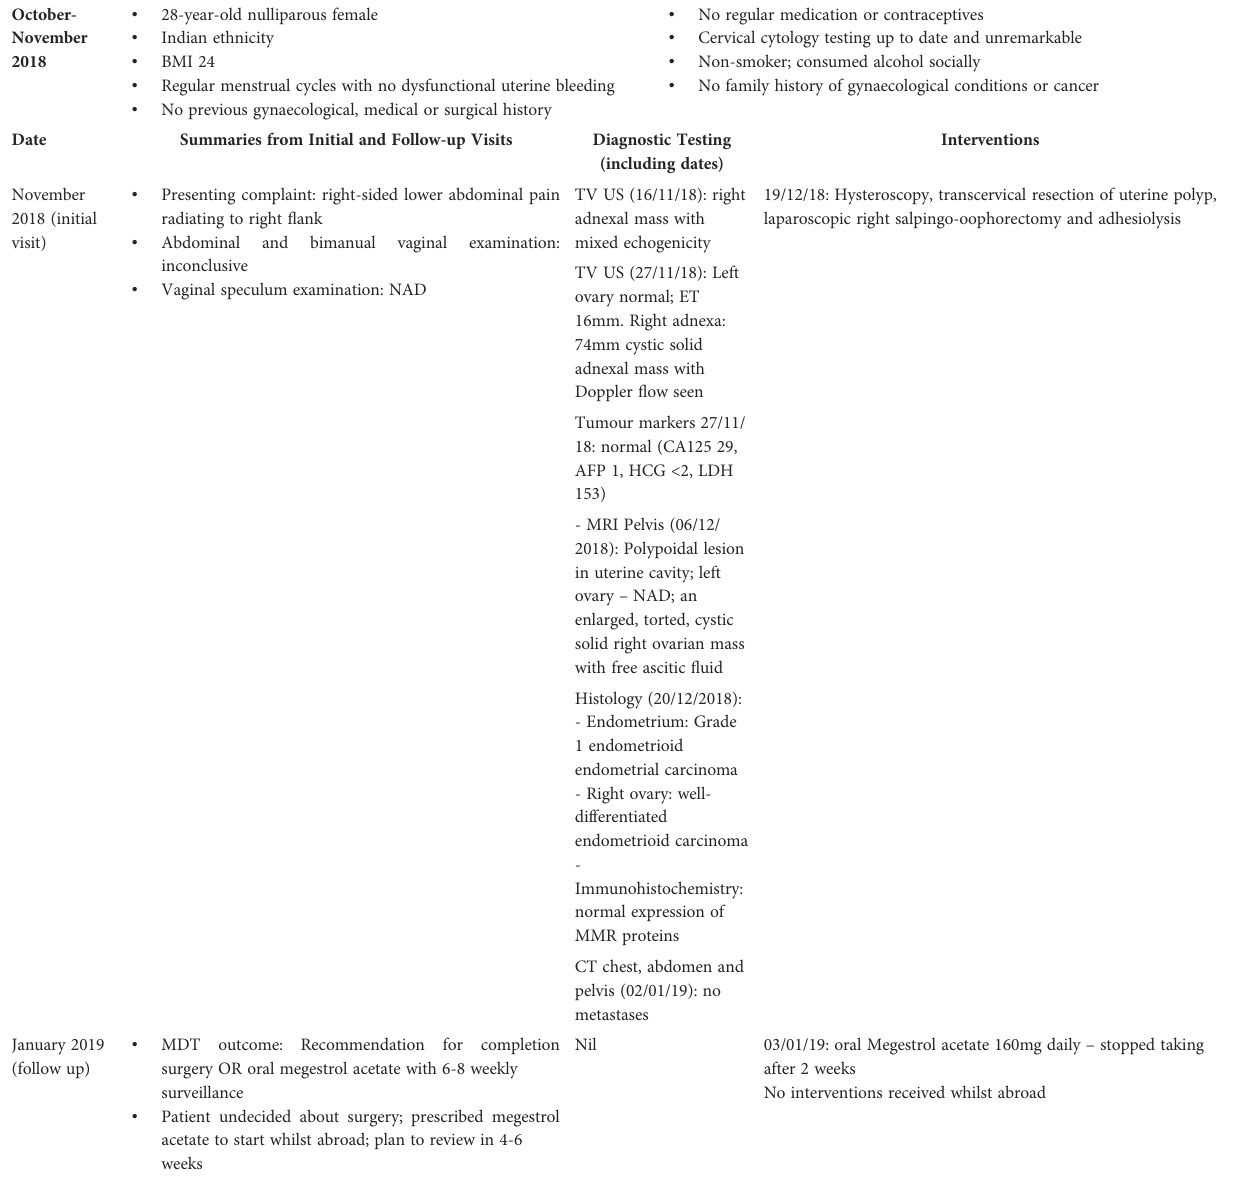
TABLE 1 Timeline of relevant historical and current data from the episode of